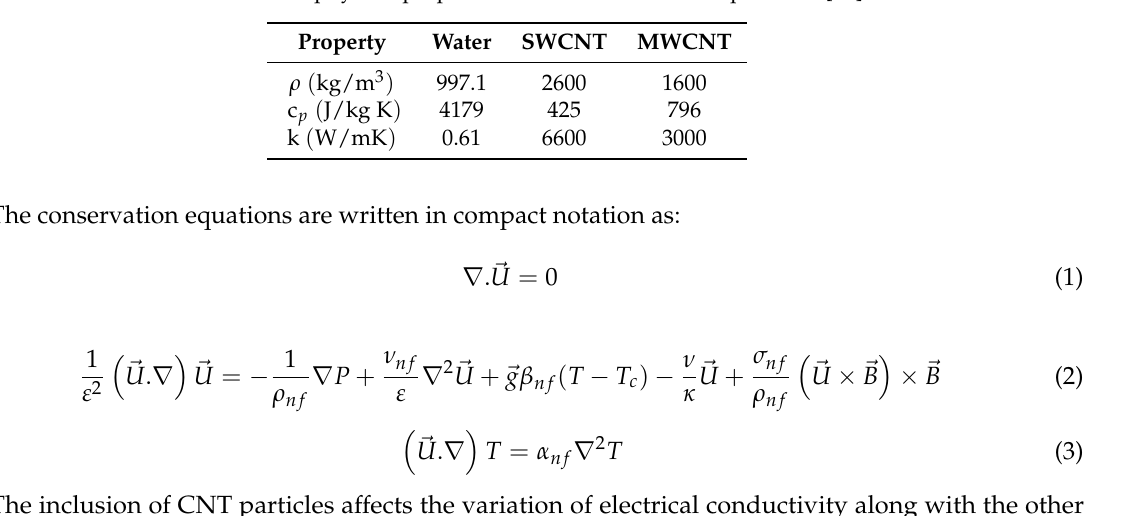
Table 1. Thermophysical properties of base fluid and nanoparticles